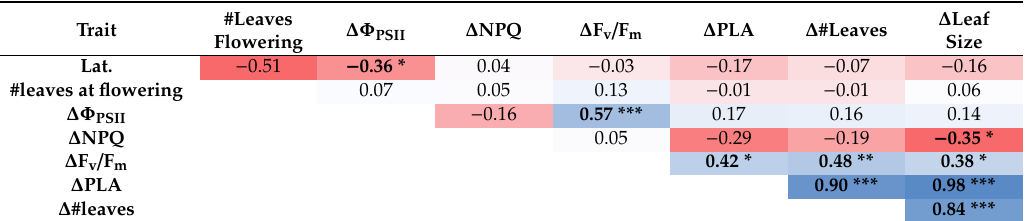
Figure 6. Relationships between photosystem II maximum quantum efficiency (F v /F m ) and ( A ) projected leaf area, ( B ) the number of visible leaves and ( C ) the number of leaves required until flowering, in 36 Arabidopsis accessions acclimated to uniform (U) and fluctuating light intensities (FL). Data from plants grown under FL are sorted by experiment 1 (squares) and experiment 2 (triangles). Averages ± SE (n = 5–7). Spearman’s ρ and the significance of a linear correlation through all points is shown (** = p < 0.01, * = p < 0.05). Next, we tested whether response ratios of parameters derived from FL over U grown plants (FL/U) correlated at the trait level, as well as with latitude of origin and number of leaves until flowering (Table 3). This analysis showed a strong, positive correlation between ΔΦ PSII and Δ F v /F m Table 3. Correlation matrix for response ratio in traits under fluctuating light divided by those under uniform light ( ∆ = FL / U). Blue colored backgrounds indicate a positive correlation, red indicates negative; the more strongly colored the background, the steeper the slope of the correlation. Statistically significant correlations ( p < 0.05) are marked in bold. Numbers indicate Spearman’s ρ , stars indicate the significance of the correlation, as: *** = p < 0.001, ** = p < 0.01 and * = p < 0.05 (n = 15–36). Lat., latitude of origin ( ◦ ), #leaves flowering, number of leaves at